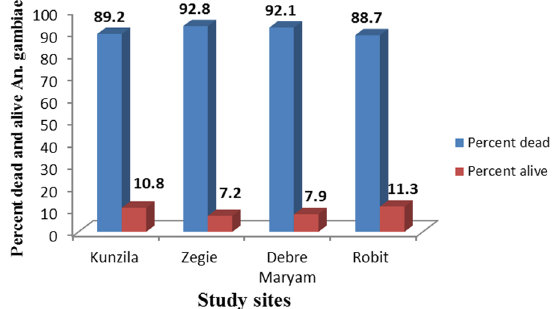
Table 1 Interaction effects of study sites and insecticides tested